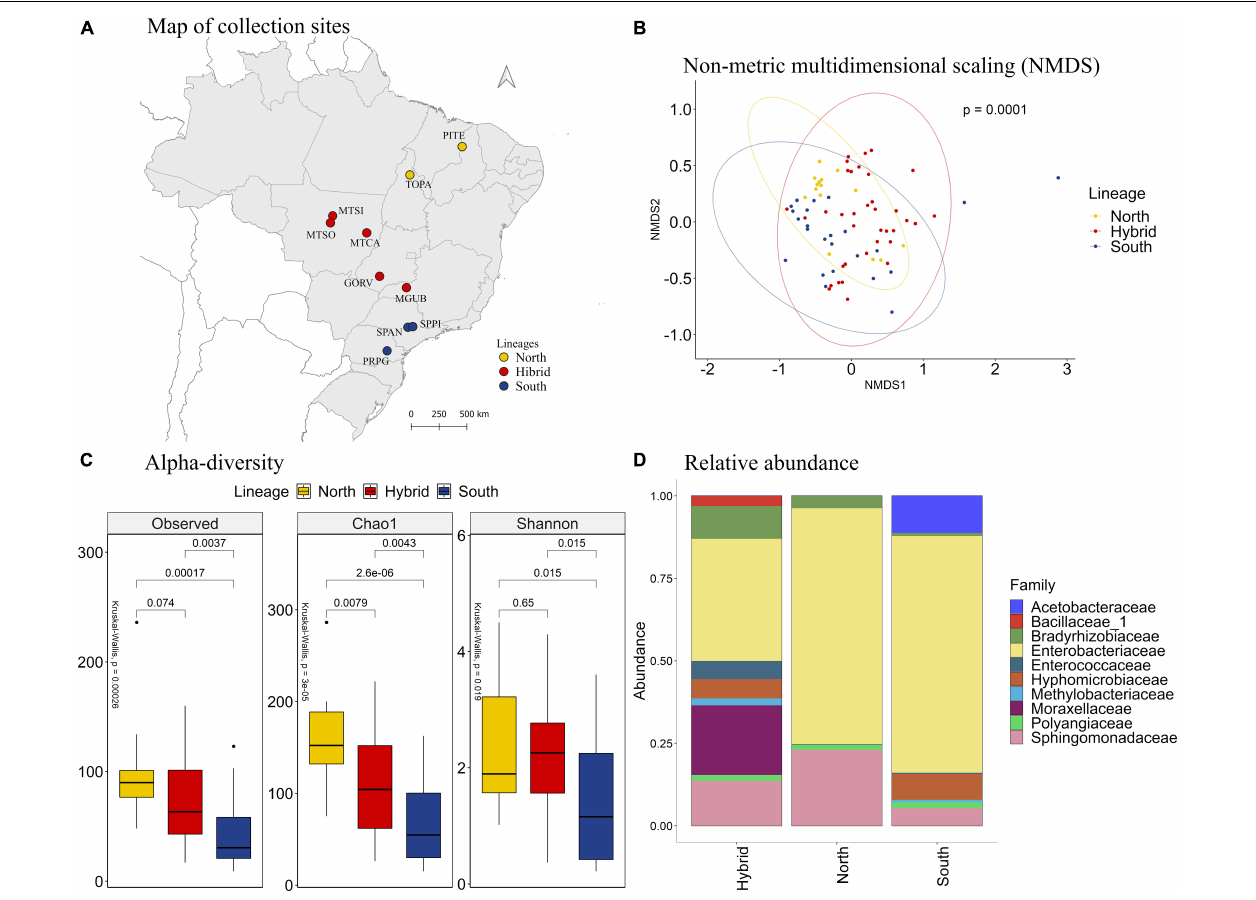
FIGURE 2 | (A) Map of collection sites of E. heros , classified by lineages in Brazil. (B) NMDS of Bray-Curtis similarity matrix among 75 samples from the intestinal microbiome of E. heros , for the different lineages. The ellipses are showing clustering between lineages. Permutational multivariate analysis of variance (PERMANOVA) is indicated in the upper right. (C) Alpha diversity levels based on Observed OTU, Chao1 index and Shannon index for the different lineages. The non-parametric test (Kruskal–Wallis) is indicated in the upper left of each graph. Pairwise comparison (Wilcoxon) is indicated between lineages. (D) Analysis of the ten most abundant bacteria families in the intestinal microbiome of E. heros collected in Brazil, classified by lineages.